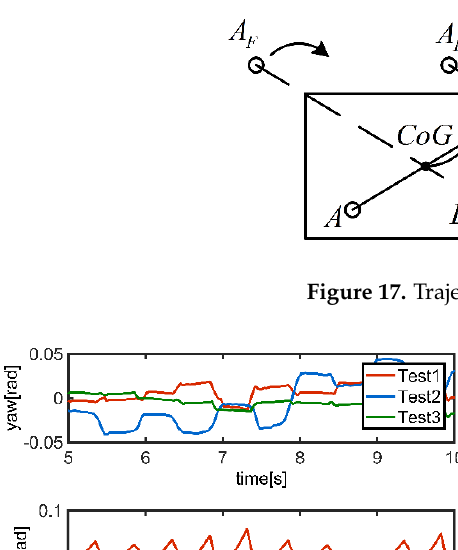
Figure 17. Trajectory of the CoG in Test 3.